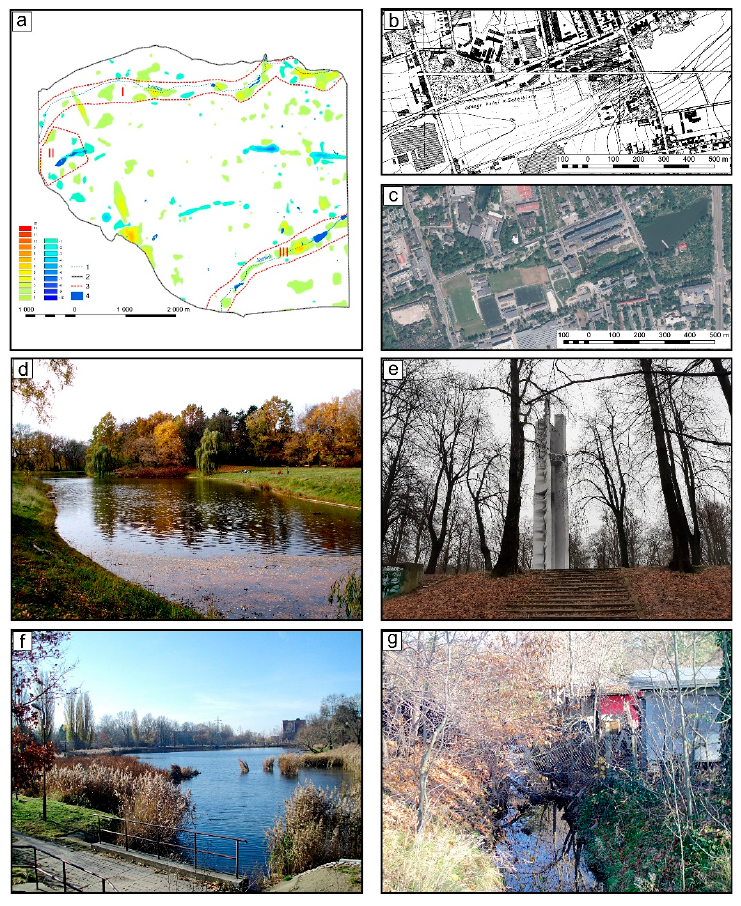
Figure 17. Changes in the relief of Ł ód ź associated with the levelling of river valleys (photo A. Szmidt, I. Ja ż d ż ewska 2021). ( a ) location map (1—course of rivers at the beginning of the 20th century; 2—water bodies existing at the beginning of the 20th century; 3—borders of Jasi ń ski’s Map development; 4—areas of analysis; ( b ) topographic situation of a fragment of the Jasie ń valley on Jasi ń ski’s Map; ( c ) aerial photo of a fragment of the Jasie ń valley from 2018; ( d ) one of the ponds in Pi ł sudski Park; ( e ) An artificial hill with a monument in Pi ł sudski Park; ( f ) one of the ponds on the Jasie ń River; ( g ) fragment of the Jasie ń River canal.